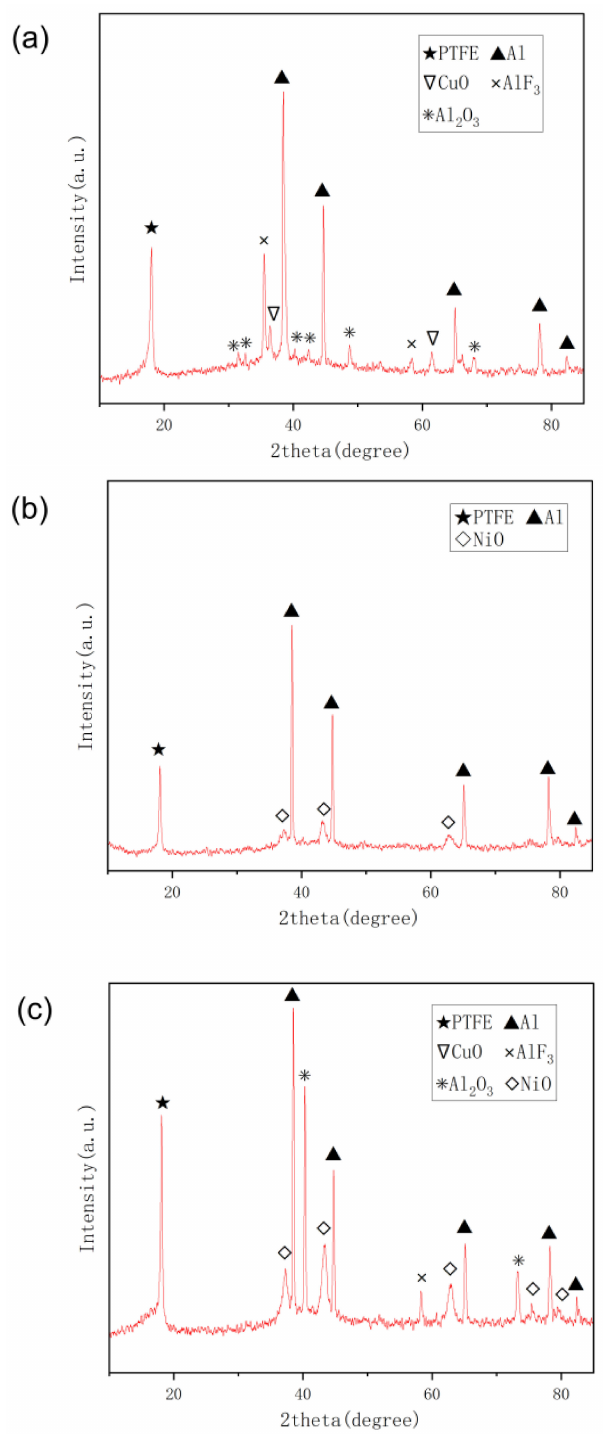
Figure 10. XRD analysis of different reactive material residues. ( a ) No.3# sample residue; ( b ) No.5# sample residue; ( c ) No.7# sample